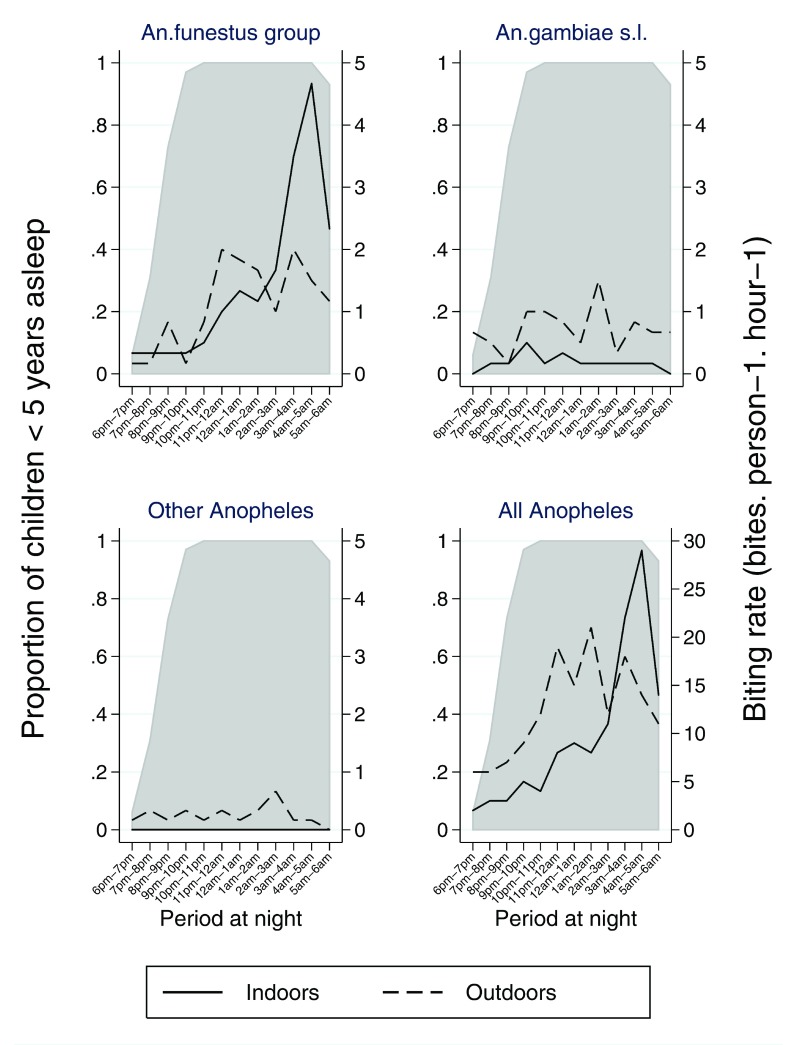
Hourly biting pattern of Anopheles mosquitoes occurring both indoors (solid lines) and outdoors (dashed lines) for the 3 separate taxa and overall.The grey area represents the proportion of the children < 5 years asleep at each hour of the night.